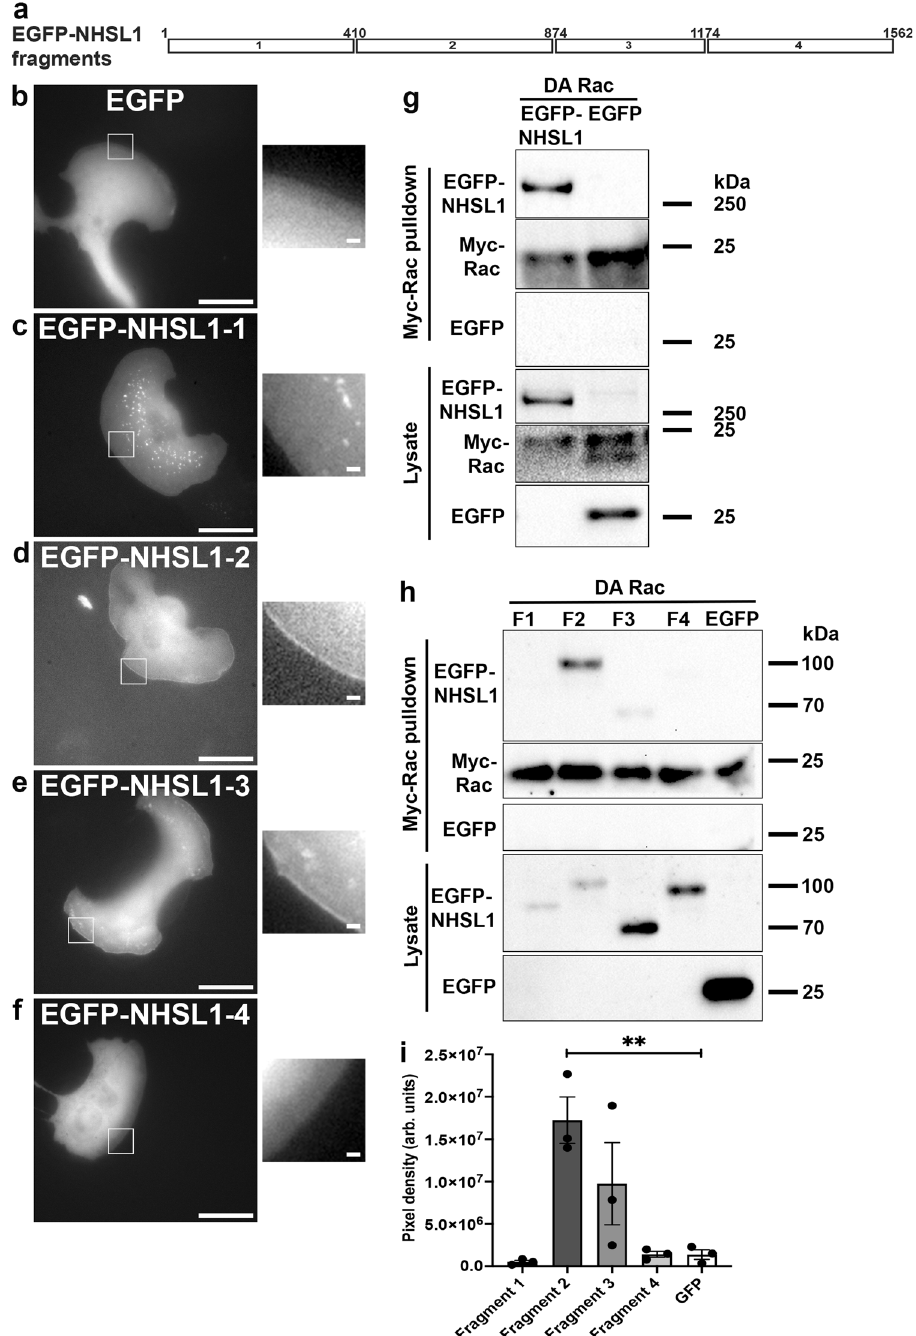
Fig. 3 NHSL1 is a binding partner of active Rac. a Scheme of NHSL1 protein: EGFP-fusion proteins 1 to 4 of NHSL1 are indicated (white rectangles). b – f Four EGFP-tagged fragments covering the entire length of NHSL1 (Figs. 1e and 3a) were generated and expressed in B16-F1 cells ( c – f ) along with EGFP as a negative control ( b ). Insets show enlarged pictures of the boxed areas from stills taken from live-cell imaging. Fragments 2 and 3 localise to the very edge of lamellipodia similar to full-length NHSL1. Representative images from three independent experiments. Scale bar: 20 μ m. Inset represents a magni fi ed view of the white box. Scale bar in inset: 1.25 μ m. See also related Supplementary Movie 5. g Western blot showing that dominant active (DA) Rac pulls down NHSL1 using Myc-trap beads from HEK cell lysates expressing Myc-tagged DA Rac co-expressed with EGFP-tagged NHSL1 or EGFP only as control. Representative blots from three independent biological repeats (see Supplementary Fig. 6a for full western blots). h Western blot showing Myc-tagged DA Rac pulldowns of the four NHSL1 fragments (see panels a and b – e ) from HEK cells expressing the EGFP-tagged fragments covering the entire length of NHSL1 or EGFP only as control co-expressed with Myc-tagged DA Rac. Representative blots from three independent experiments. i Quanti fi cation of band intensity of chemiluminescence from h imaged with a charge-coupled device (CCD) camera shows that Myc-tagged DA Rac binds signi fi cantly to fragment 2 compared to GFP. The amounts of EGFP-NHSL1 fragments were normalised to the amount of Myc-Rac that was pulled down. Bars indicate mean ± SEM (error bars), n = 3 biological repeats. One-way ANOVA: P = 0.003, F (4,10) = 8.473; and Dunnett ’ s multiple comparisons tests: ** P = 0.004. Source data are provided as a Source Data fi